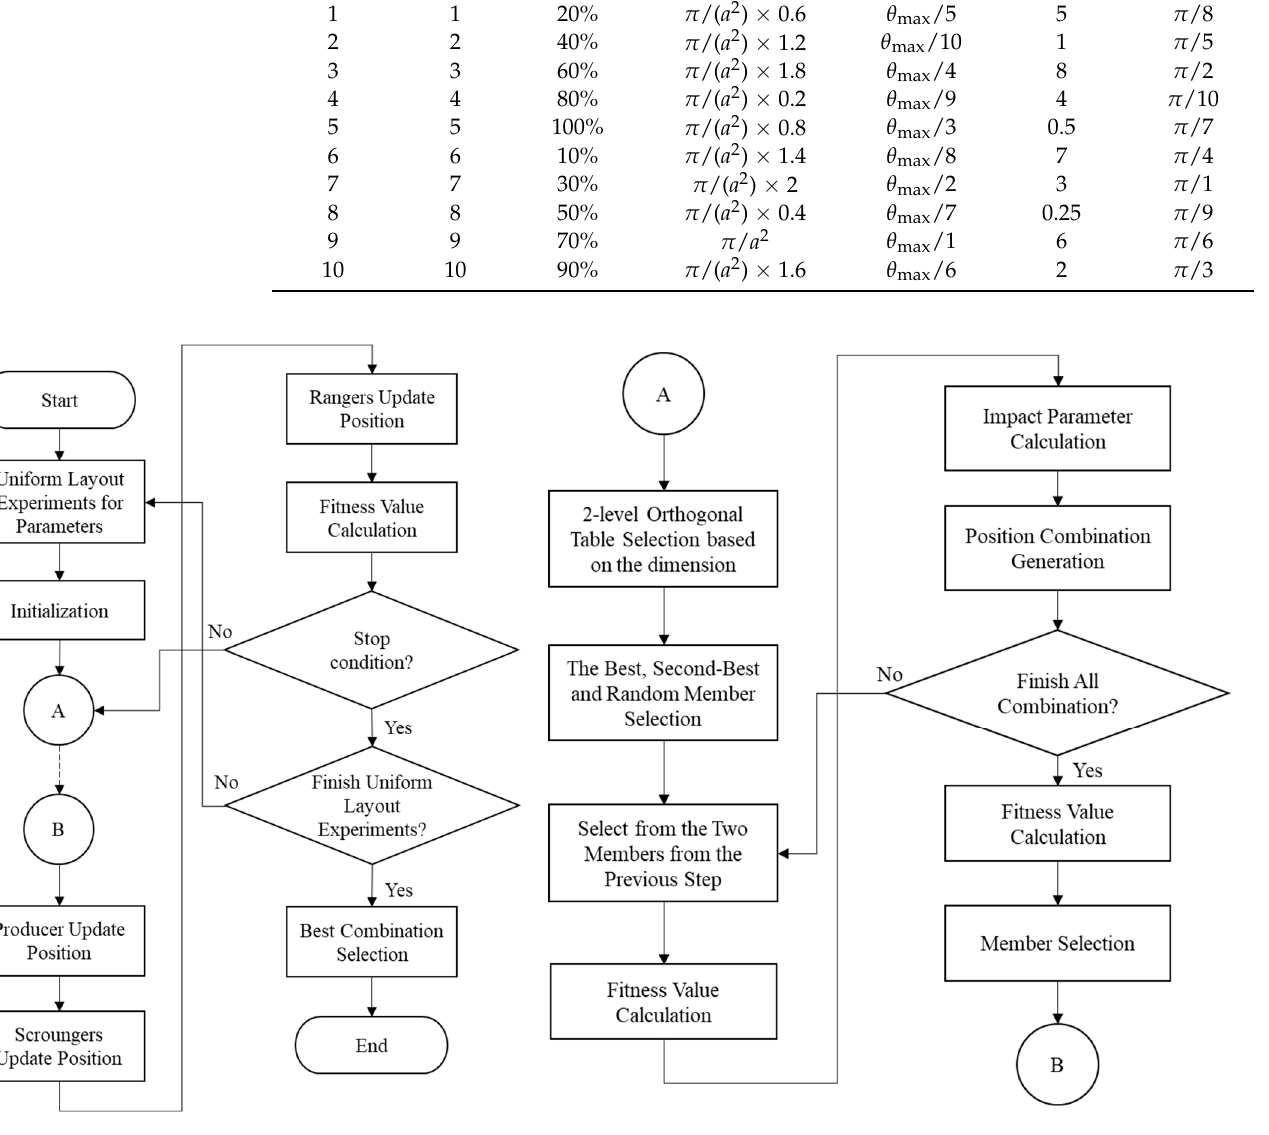
Figure 4. Flowchart of R-GSO algorithm steps.